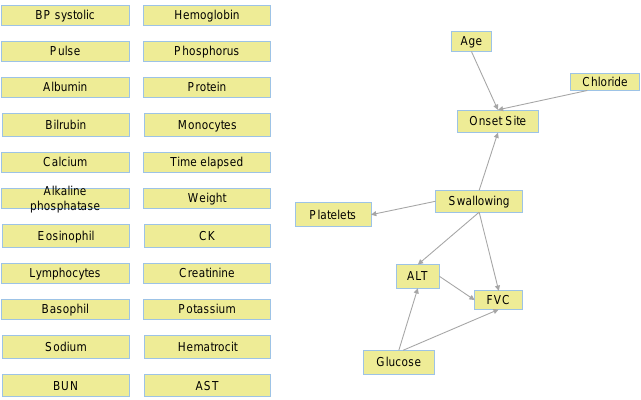
Figure 9. Complete BN graph for